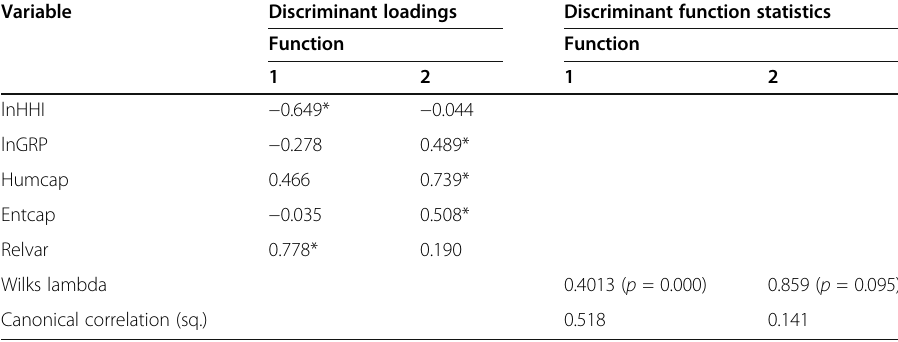
Table 6 Standardized discriminant loadings and discriminant function